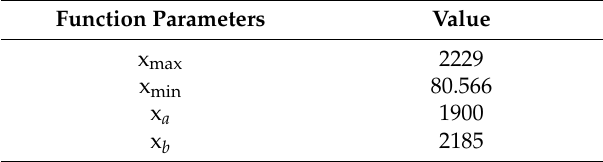
Table 3. Relative deterioration degree parameters of main hydraulic pressure.